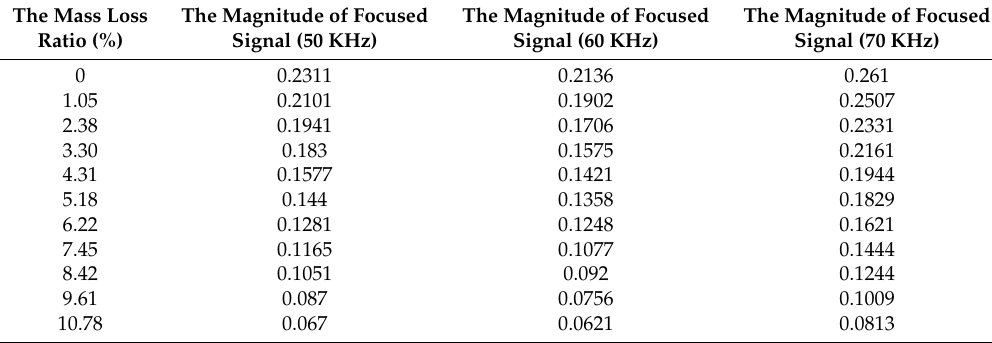
Table 2. The data of specimen no. 2.